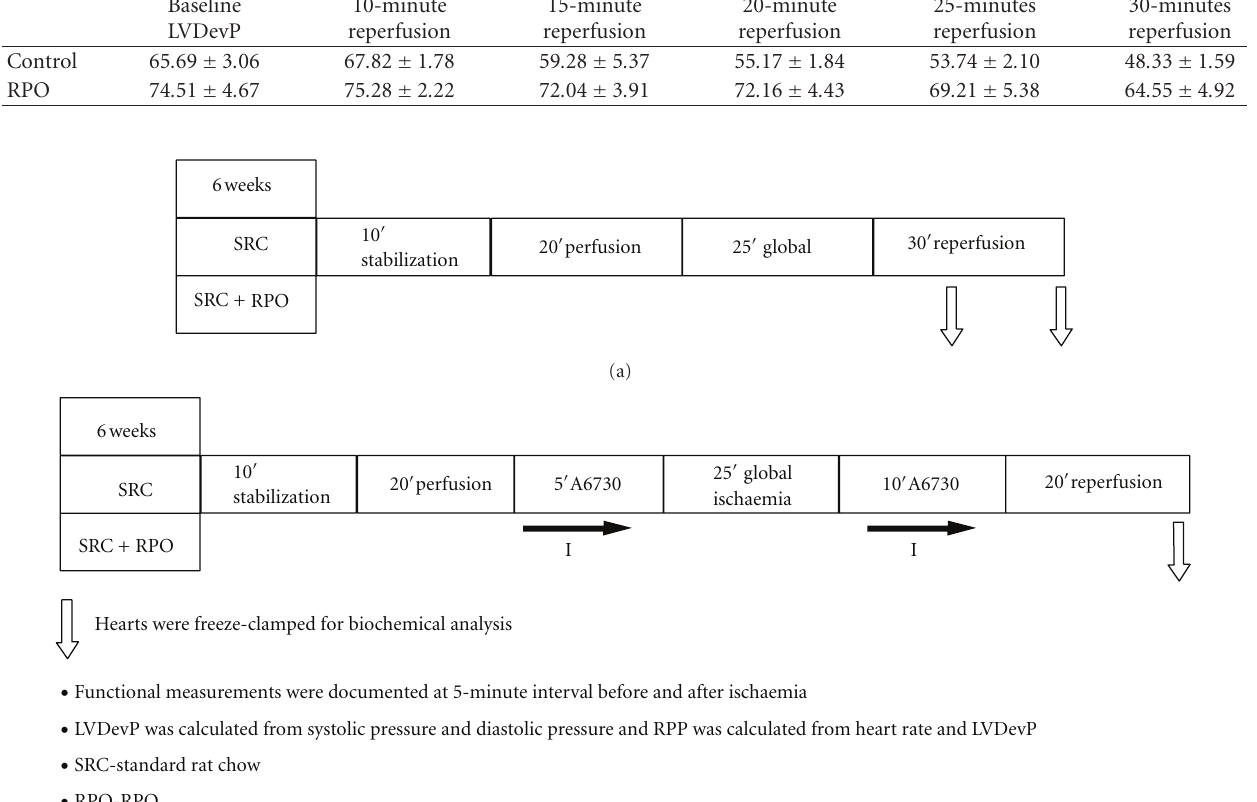
Figure 1: (a) Study design, perfusion protocol 1. (b) Study design, Perfusion protocol 2 and time points for biochemical samples were